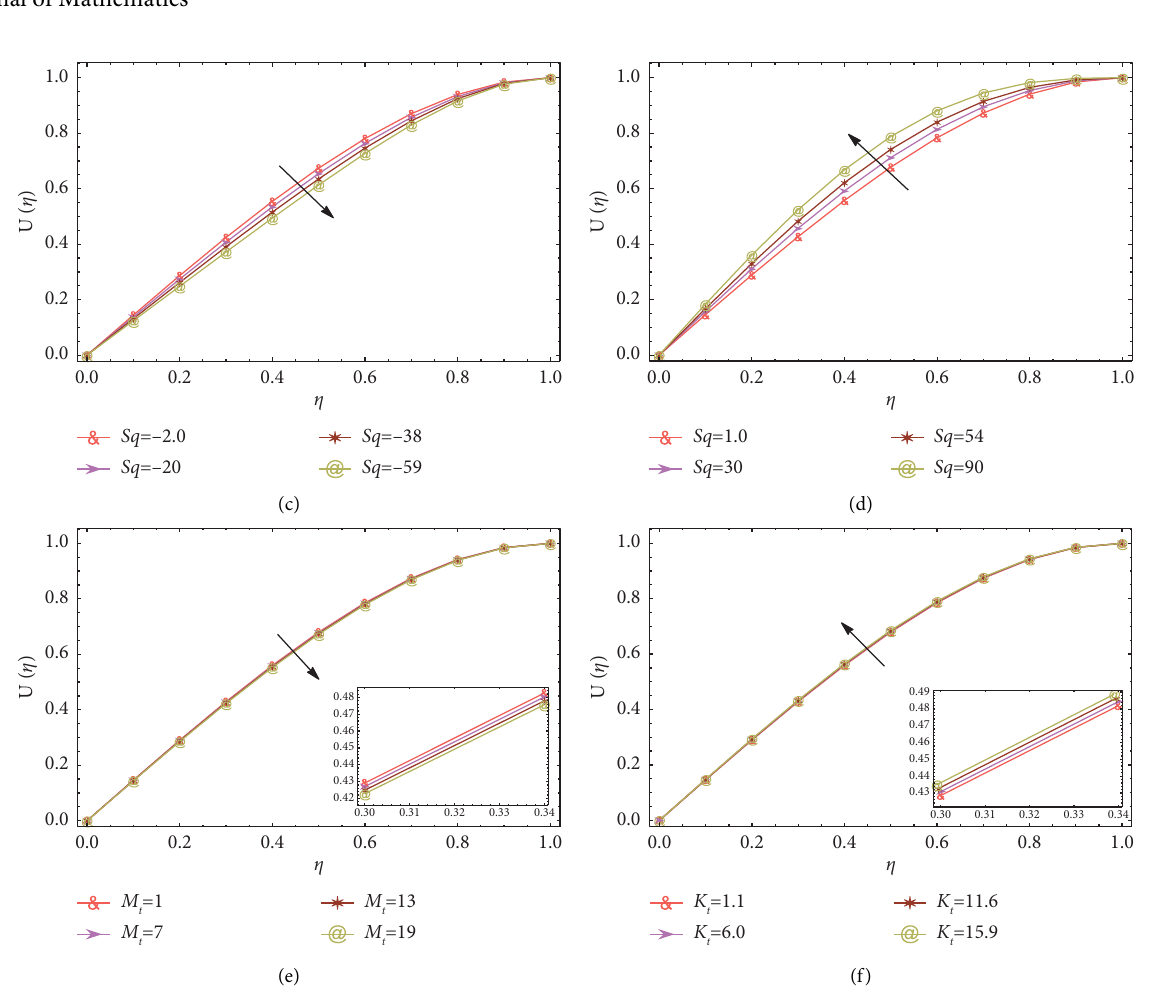
Figure 2: Efect of diferent parameters on radial velocity at α � 0 . 85. Table 3: Numerical values of skin friction for diferent values of α , β ,Sq, M t and κ t